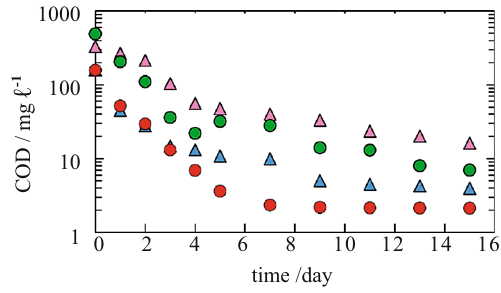
Fig. 5 Change of COD in the artificial waste water (15 L) containing 10 mL of milk, 15 mL of AS, and 750 g of PCs ( red circles ) or without the PC ( blue triangles ), and that in the water containing 100 mL of milk, 15 mL of AS, and 750 g of PC ( green circles ) or ‘‘without the PC’’ ( pink